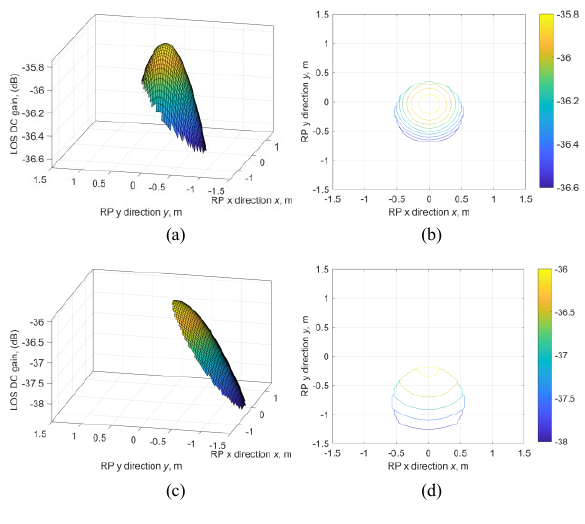
Figure 4 (a - b) surface and contour plot for α = 5 o , and (c – d) surface and contour plot for α = 20 o